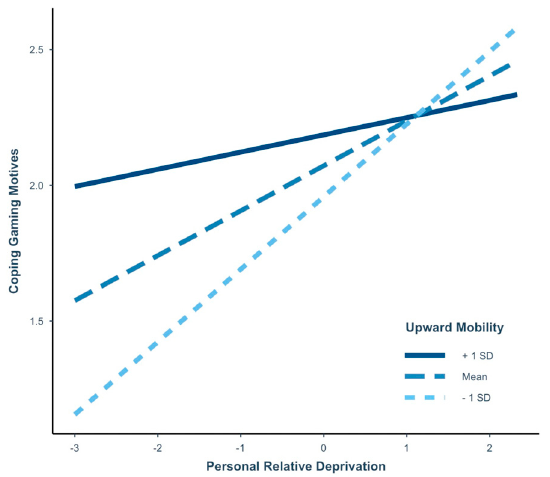
Figure 3. The conditional effect of perceived upward mobility on personal relative deprivation and coping video game motives for Study 2. All variables were coded to reflect more of the construct, with average scores computed for each participant. This figure represents the association between personal relative deprivation and coping gaming motives for MTurk participants at three levels of perceived upward mobility: (1) +1 SD above the mean, (2) the mean, and (3) -1 SD below the mean. Covariates included gender, income, loneliness, negative urgency, and positive urgency. n = 179. Moreover, a significant moderated mediation effect was found in this model (Index = − 0.05, SE = 0.03, 95% CI [ − 0.12, − 0.003]). This finding indicates the indirect relationship